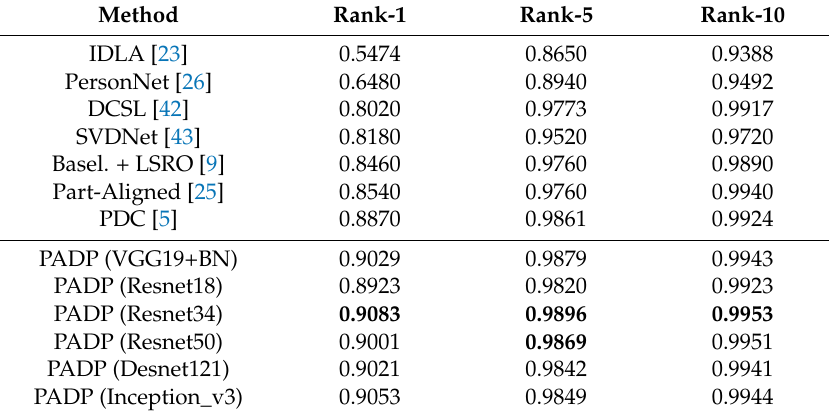
Table 4. Rank-1, rank-5 and rank-10 of various methods on the CUHK03